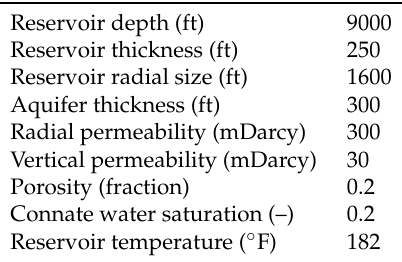
Table 3. Properties of the reservoir